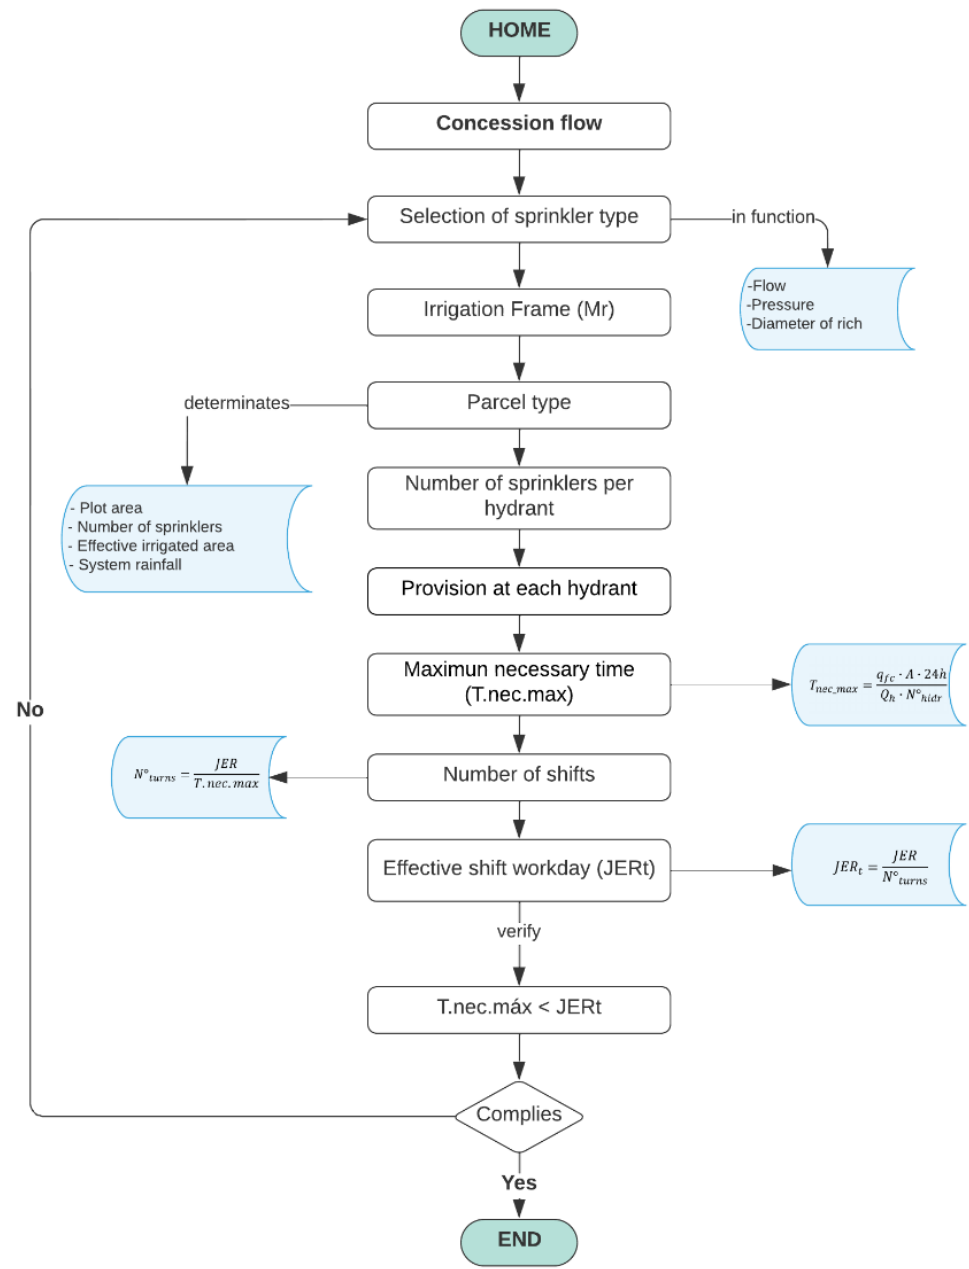
Figure 4. Flowchart of the design flow rate procedure for shift design flows.